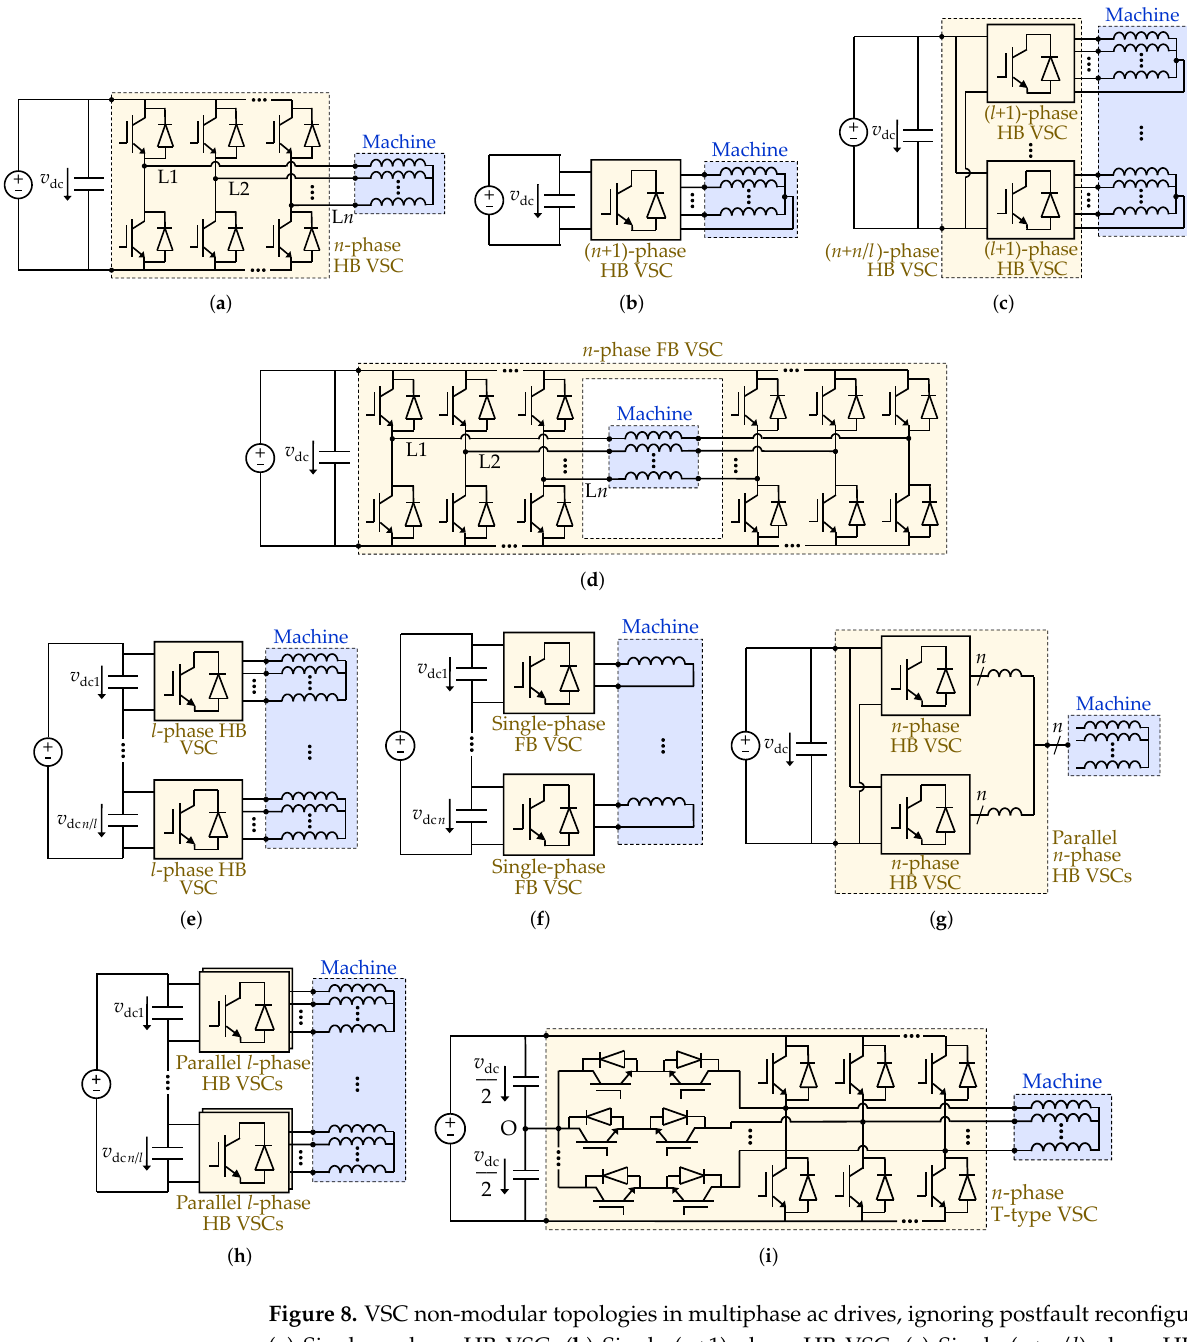
Figure 8. VSC non-modular topologies in multiphase ac drives, ignoring postfault reconfiguration. ( a ) Single n -phase HB VSC. ( b ) Single ( n +1)-phase HB VSC. ( c ) Single ( n + n / l )-phase HB VSC. ( d ) Single n -phase FB VSC for open-end windings. ( e ) Series dc-side connection of l -phase HB VSCs. ( f ) Series dc-side connection of single-phase FB VSCs. ( g ) Parallel n -phase HB VSCs. ( h ) Series dc-side connection of parallel l -phase HB VSCs. ( i ) Single n -phase T-type three-level